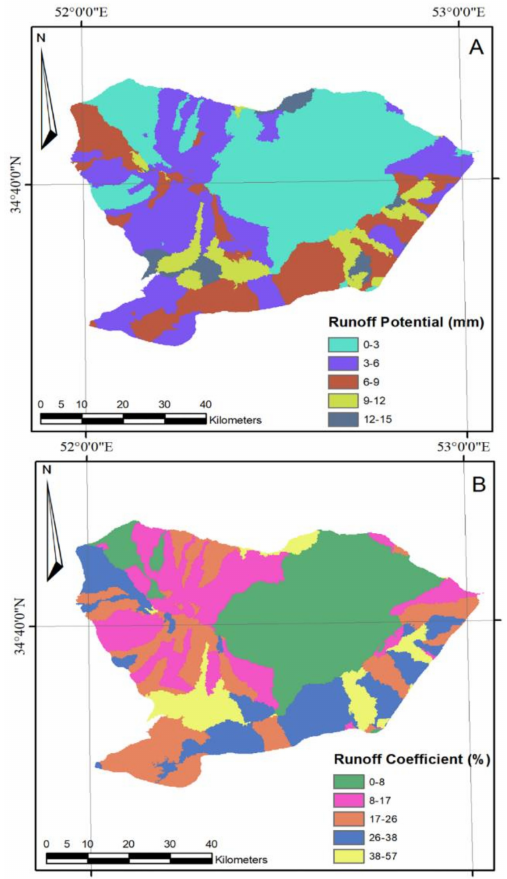
Figure 12. Runo ff potential map ( A ) calculated using the 33% exceedance probability of maximum daily rainfall and runo ff coe ffi cient ( B ) mapped as the ratio between runo ff potential and design rainfall for Kavir National